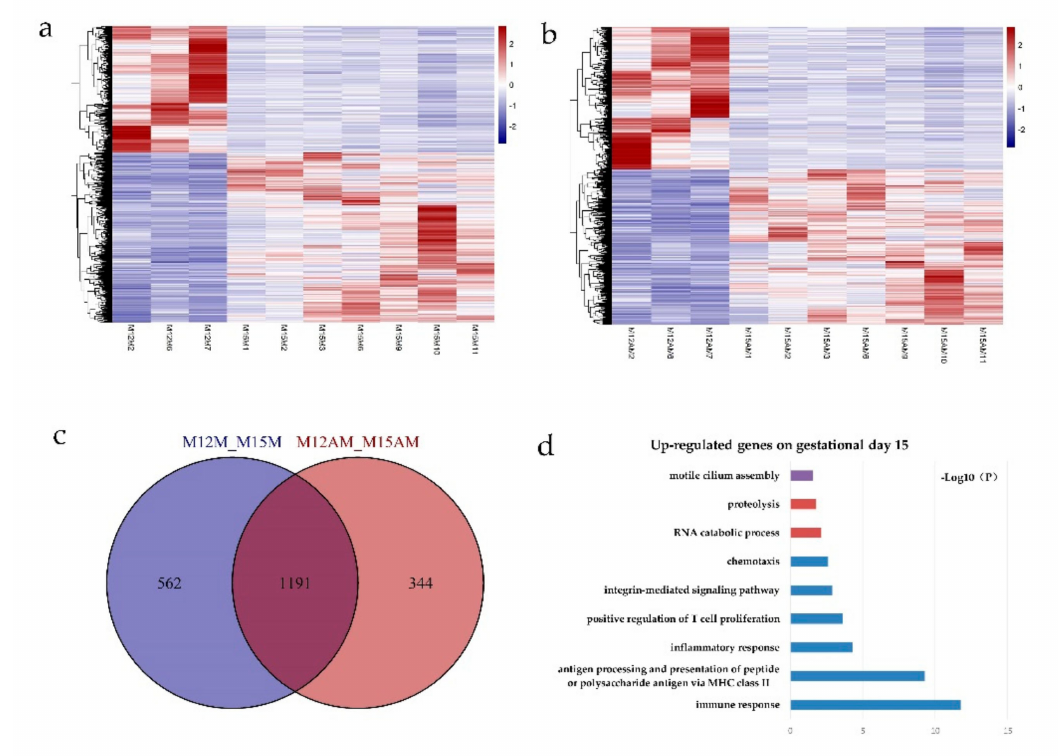
Figure 2. Gene expression profiles between the mesometrial side and anti-mesometrial side of uterus during implantation. ( a ) Expression profiles of the di ff erentially expressed genes at the mesometrial side of the uterus between gestational days 12 and 15; ( b ) Expression profiles of the di ff erentially expressed genes at the anti-mesometrial side of uterus between gestational days 12 and 15. Each row represents an individual gene, and each column represents a sample. The color legend at the top indicates the level of gene expression. ( c ) Venn diagram showing the overlaps of di ff erentially expressed genes (DEGs) between the mesometrial side and anti-mesometrial side of uterus between gestational days 12 and 15. ( d ) Gene Ontology (GO) analysis of the up-regulated DEGs on gestational day 15. Blue column represents GO terms for DEGs that were common to both the mesometrial and anti-mesometrial side, red column represents GO terms for the DEGs that were unique to the mesometrial side, and purple column represent GO terms for DEGs that were unique to the anti-mesometrial side. The negative log of the P-value (-log10P) was plotted on the x-axis. M12M, gestational day 12 at the mesometrial side of the uterus; M12AM, gestational day 12 at the anti-mesometrial side of the uterus; M15M, gestational day 15 at the mesometrial side of the uterus; M15AM, gestational day 15 at the anti-mesometrial side of the